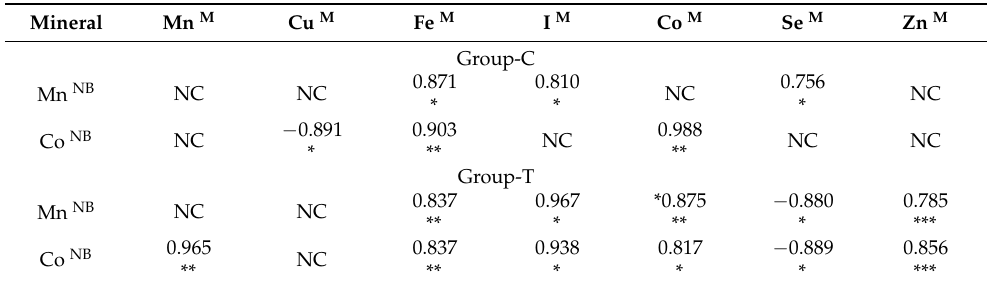
Table 8. Correlation coefficient of some trace elements for calves’ blood serum and milk. Mineral Mn